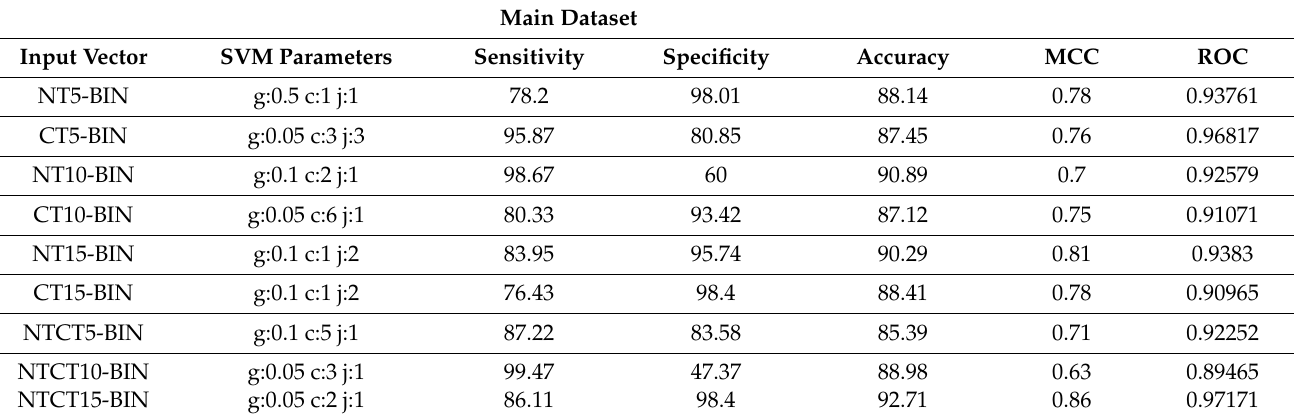
Table 3. Performances of SVM models developed using a binary profile-based method using five-fold cross-validation. Main